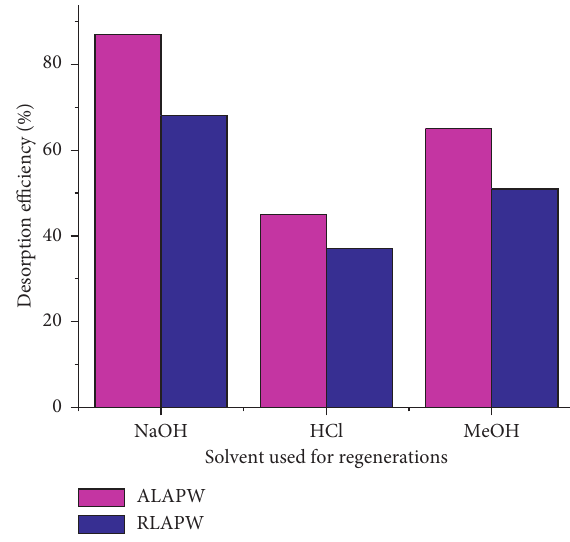
Figure 14: Desorption efficiency (%) using different solvent